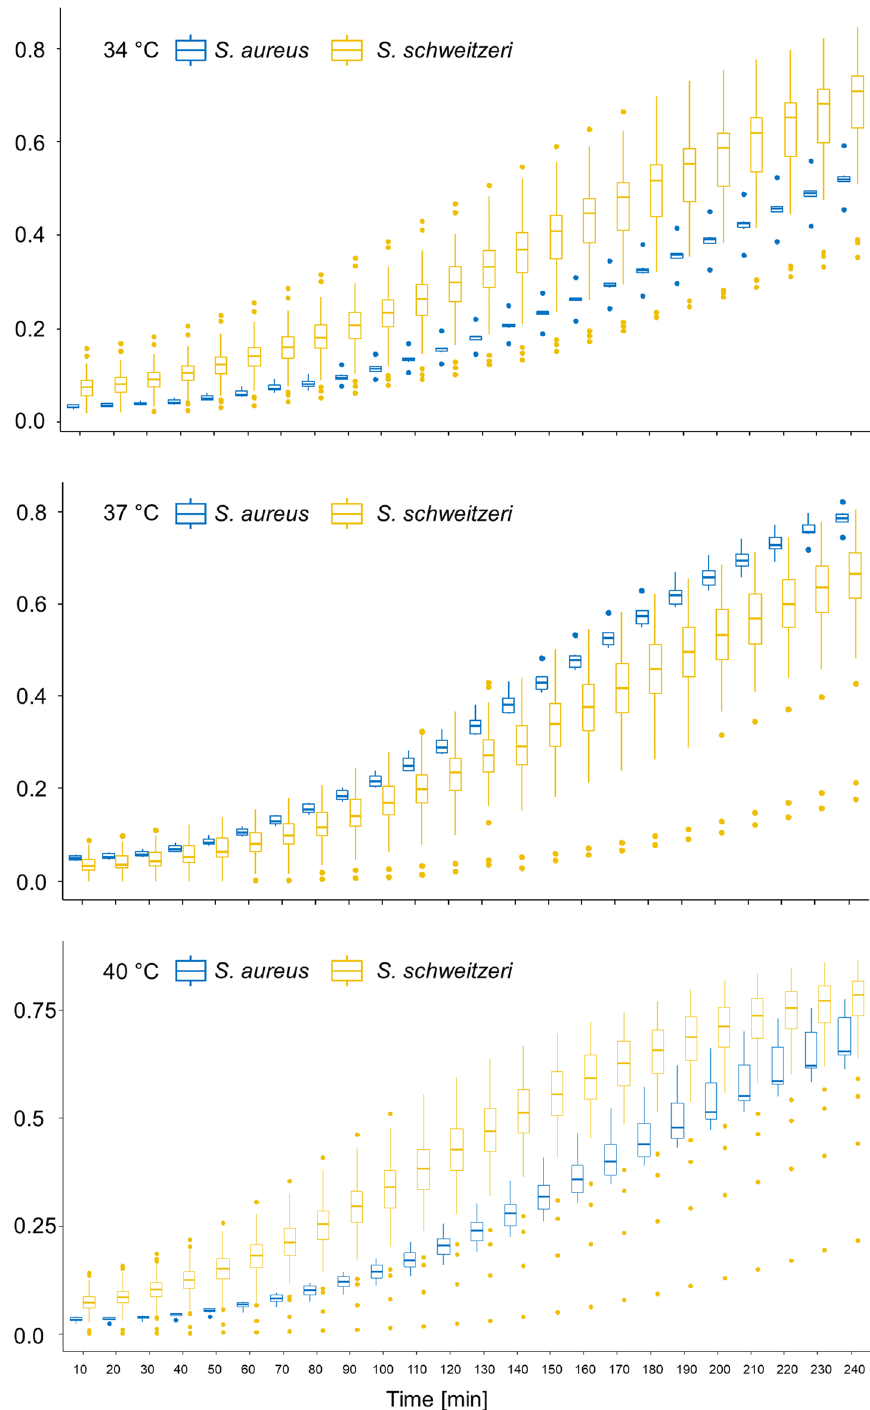
Figure 2. Growth curve of Staphylococcus schweitzeri and African Staphylococcus aureus at different temperatures. The growth of S. schweitzeri (n = 58, yellow boxplots) and a representative selection of African S. aureus (n = 6, blue boxplots) was photometrically measures after intervals of 10 min for 4 h. Boxplots (incl. outliers) of optical density (OD) are shown for each species and time points. S. schweitzeri grew faster at 34 °C and 40 °C than S. aureus comparator